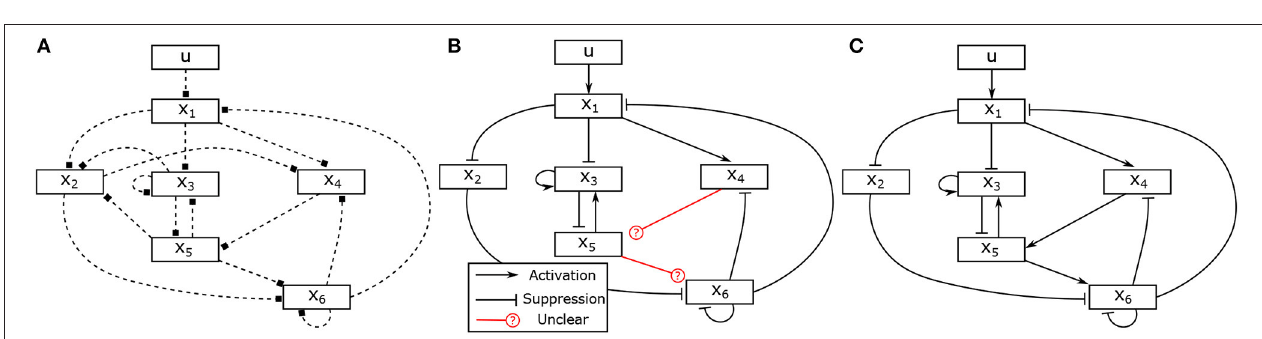
FIGURE 3 | Hypothesis, partially identified and fully identified network graph. (A) Hypotheses for regulative interactions. (B) Identified Boolean network without canalizing information. (C) Identified Boolean network with prior